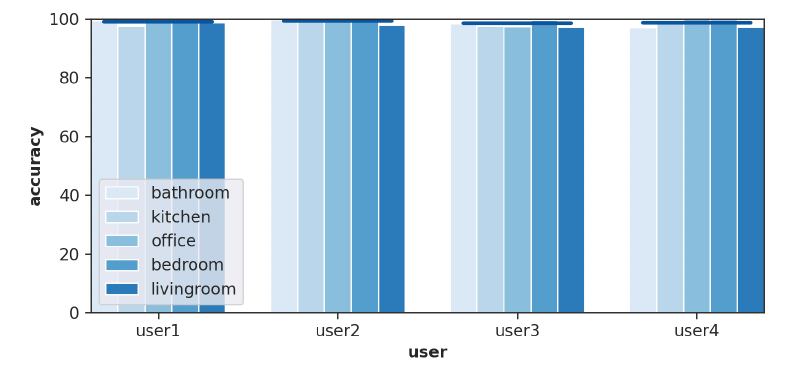
Figure 10. Results of the fingerprint method when using manual training. Accuracy is the percentage of times the system is able to correctly estimate the room with respect the ground